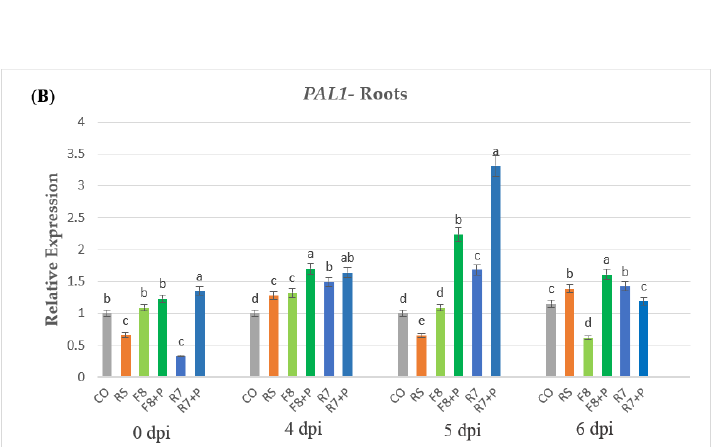
stress compared to the negative control (Figure 9A). Furthermore, the analysis of PAL1 gene expression in roots revealed an enhancement of the gene expression after the patho- gen inoculation in plants which were pretreated with S. globisporus strain F8 and S. praecox strain R7 (2.3-folds and 3.3-folds, respectively) at 5 dpi compared to negative control (Fig- ure 9B).